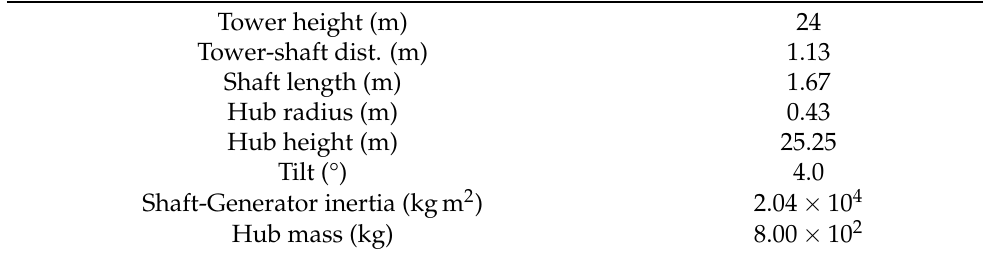
Table 1. General dimensions of the turbine model without the blade information.